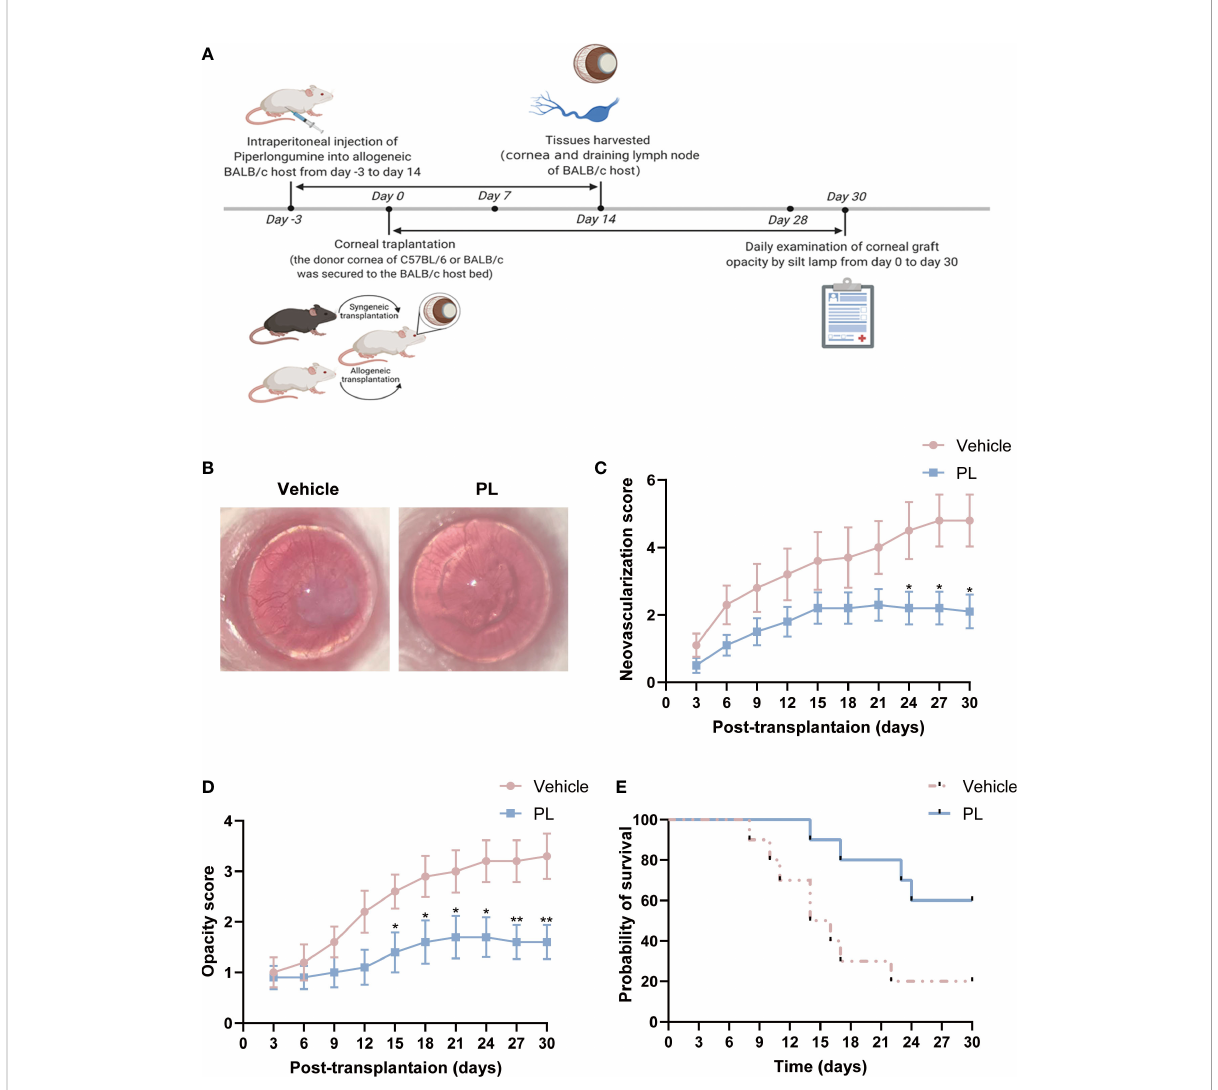
FIGURE 1 PL suppressed corneal allograft rejection in a murine model. (A) A schematic diagram depicts the experimental design for the evaluation of the therapeutic effect of PL in the murine corneal allograft transplantation model. Allogeneic BALB/C host in PL-treated group were injected intraperitoneally with PL solutions (10 mg/kg/d) from day 3 before surgery till day 14 after surgery, whereas mice in vehicle-treated group were treated with an equal volume of sterile saline. Mice in two groups were observed daily for 30 days after surgery. (B) Representative slit-lamp images of corneal grafts from two groups on postoperative day 30. (C) Neovascularization score of corneal grafts from two groups were analyzed by serial observation (n = 10/group). (D) Opacity score of corneal grafts from two groups were analyzed by serial observation (n = 10/ group). (E) Kaplan-Meier survival curve of corneal grafts from two groups were analyzed by serial observation (n = 10/group). The data are presented as mean ± SEM. * P < 0.05, ** P < 0.01. Panel (A) from